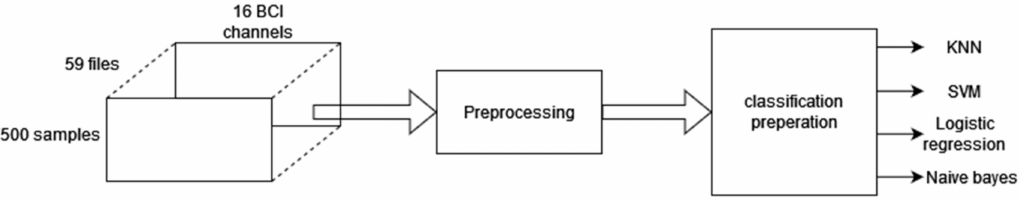
Figure 12. Signal flow from data collection to classification.